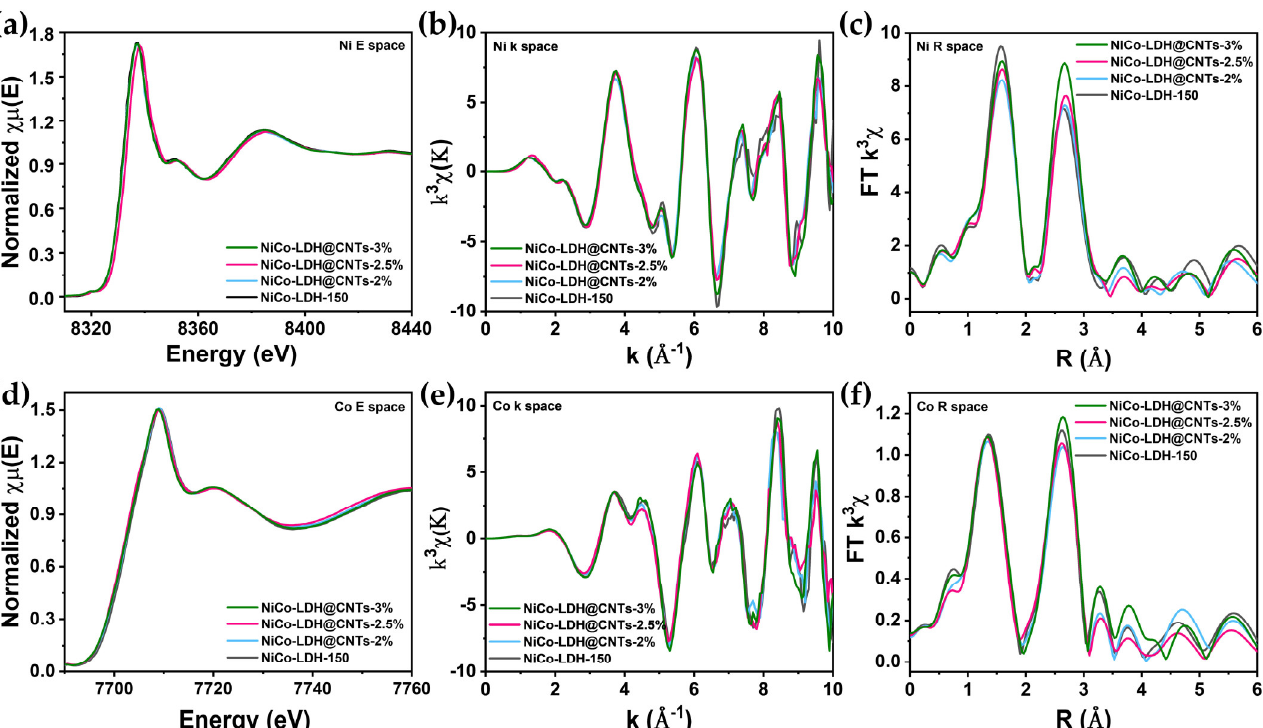
Figure 4. ( a ) Ni K-edge XANES spectra, ( b ) Ni K-edge EXAFS oscillation functions k 3 χ(k), ( c ) the magnitude of k 3 -weighted FT of the Ni K-edge extended EXAFS spectra, ( d ) Co K-edge XANES spectra, ( e ) Co K-edge EXAFS oscillation functions k 3 χ(k), and ( f ) the k 3 -weighted FT magnitude of the Co K-edge extended EXAFS spectra of NiCo-LDH-150 and NiCo-LDH@CNTs- z % ( z = 2, 2.5, and 3).